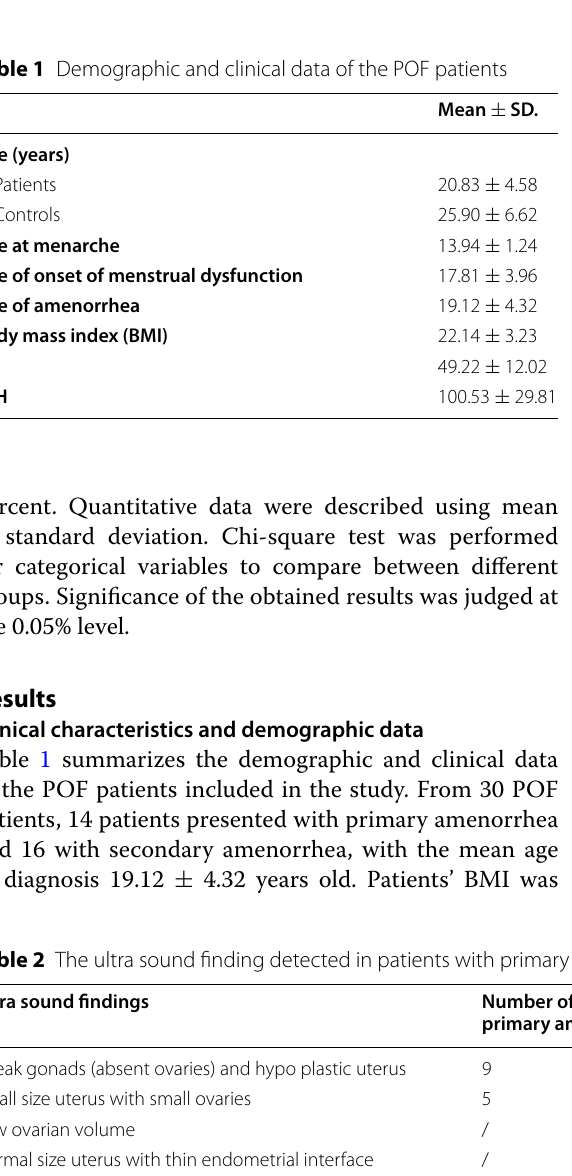
Table 1 Demographic and clinical data of the POF patients